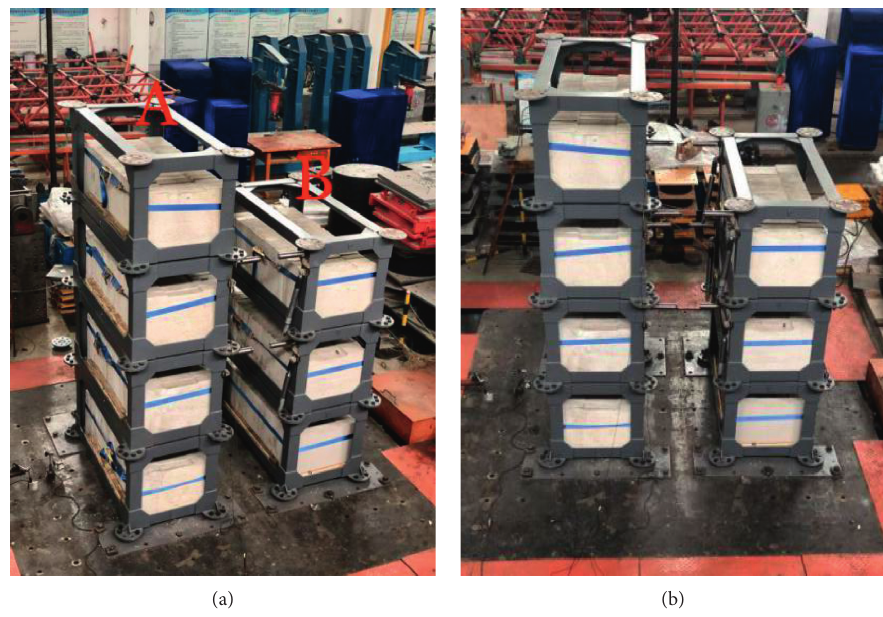
Figure 8: Model diagram of the test. (a) Elevation of the test model. (b) Top view of the test model.